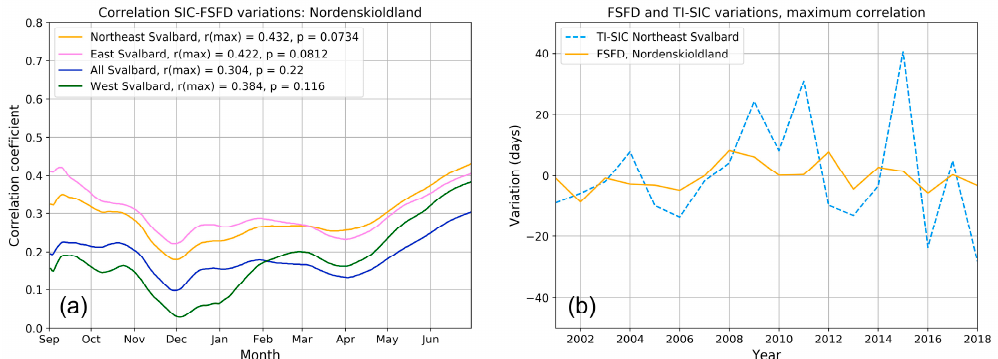
Figure A4. As for Figure A3 but for FSFD variations over Nordenskiöld Land and TI-SIC for Northeast Svalbard.